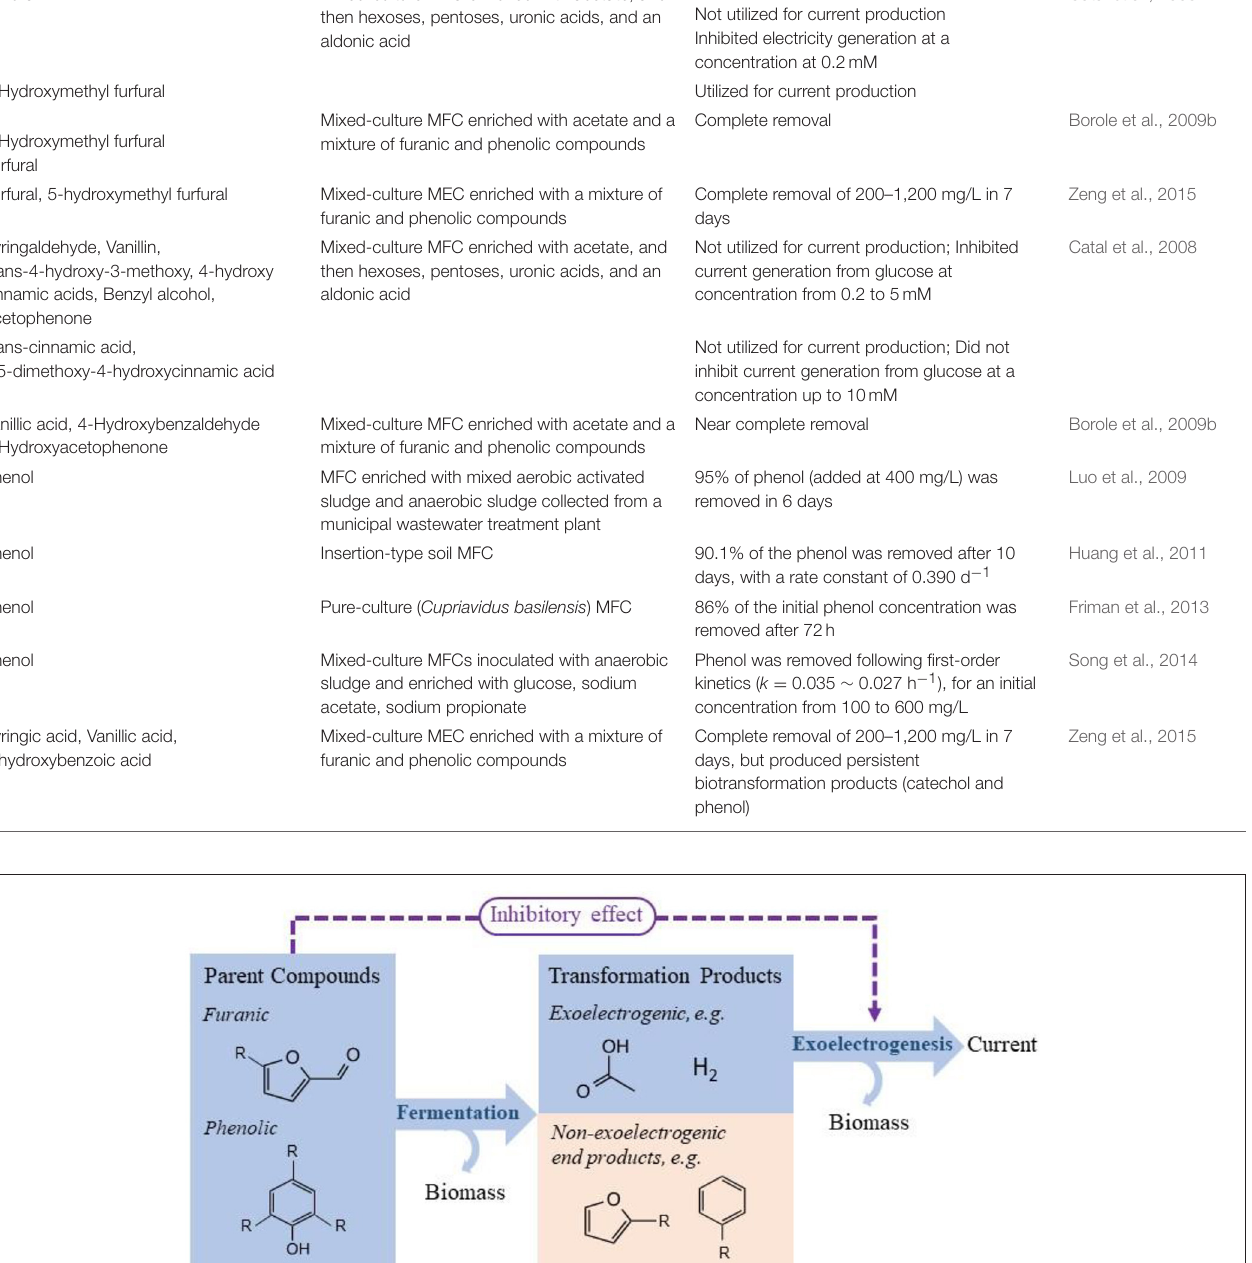
4-hydroxy cinnamic acids at a concentration above 20 mM, as well as benzyl alcohol and acetophenone at 0.2 mM, severely inhibited electricity generation from glucose using a MFC.